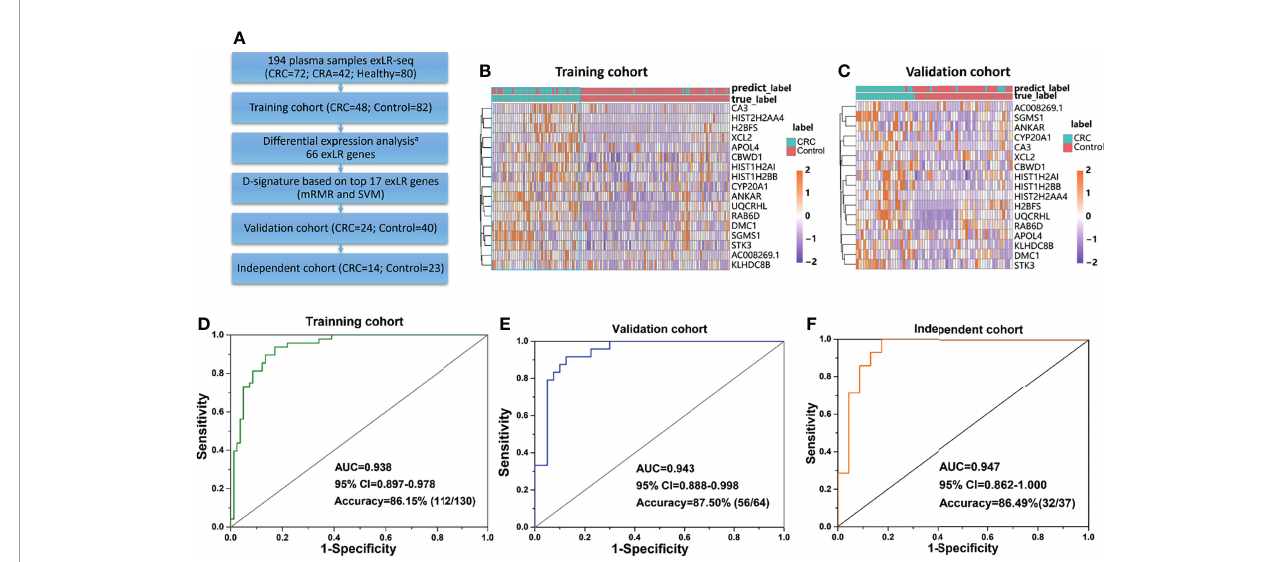
FIGURE 2 | Establishment of the exLR d-signature. (A) Flowchart of establishment of the d-signature. (B, C) Unsupervised hierarchical clustering of the 17 genes in training cohort (B) and validation cohort (C) . (D – F) ROC curve for the exLR d-signature in the training (D) , validation (E) , and independent (F) cohorts. a Selection of lncRNA or protein-coding genes with (1) expression frequency >0.5; (2) log2(FC) >0.59, adjusted p value <